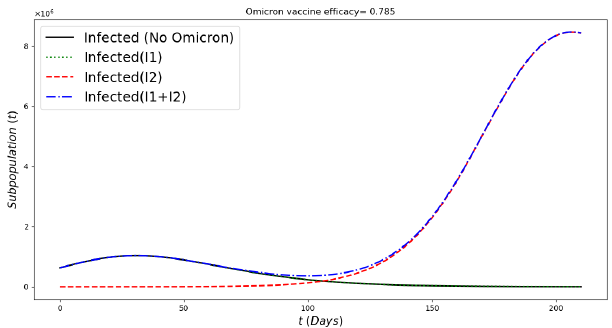
≈ 0.81, R ≈ 1.74 and 0 2 1